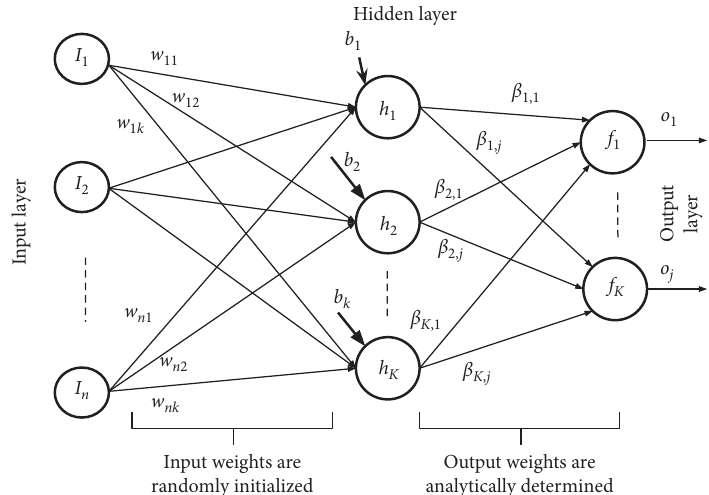
Figure 3: The architecture of the single hidden layer ELM model.